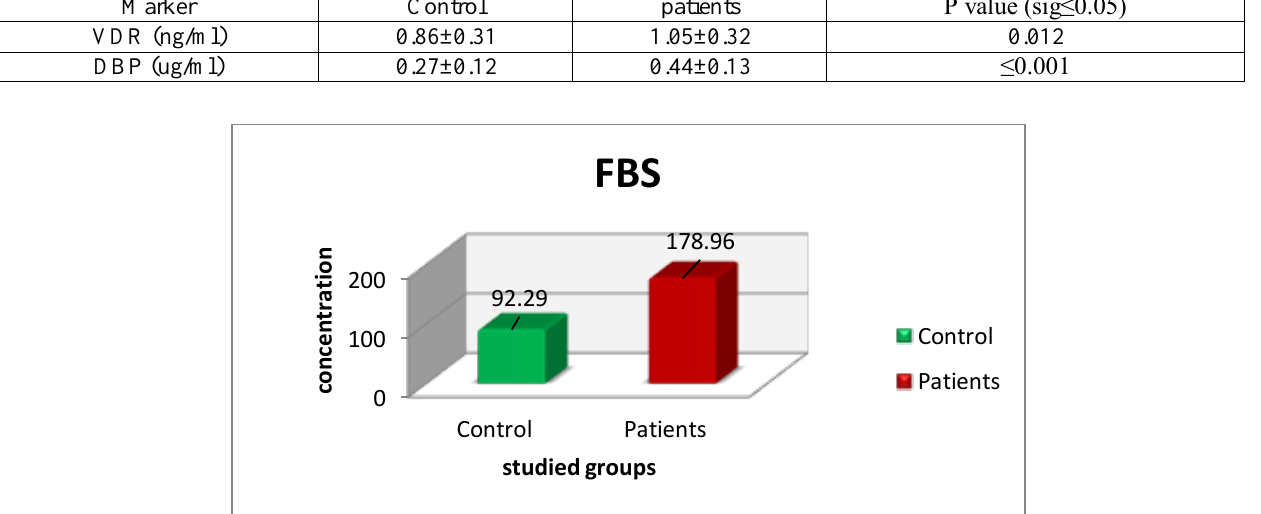
Figure 4: Vitamin D binding protein levels in patients and control